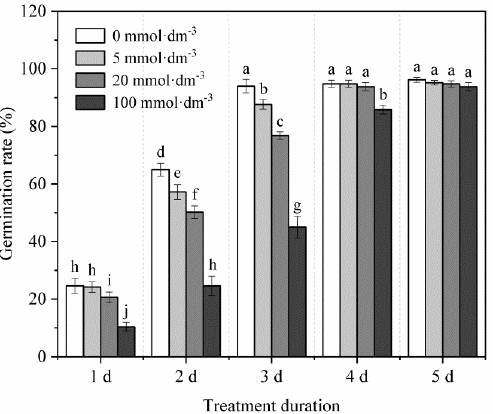
Figure 1. Effects of IDS on maize seed germination. Maize seeds were treated with different concen- trations (0, 5, 20, and 100 mmol·dm −3 ) of the chelating agent IDS. The number of germinated maize seeds was recorded at 1, 2, 3, 4, and 5 d after sowing. Error bars represent the standard deviation of the mean ( n = 5). Means associated with different letters are significantly different between treatments and time points ( p < 0.05; Duncan’s new multiple range test). IDS, iminodisuccinic acid. Although the final GR of seeds was reduced to approximately 18% under heavy metal stress (20 mmol·dm −3 PbCl 2 ), the IDS treatment effectively alleviated the inhibitory effect of Pb stress on seed germination in maize (Figure 2). For instance, compared with the GR after the treatment with Pb alone, the GR after the treatment with 100 mmol·dm −3 IDS under conditions of Pb stress was approximately 2.03-, 1.85-, 1.86-, 1.92-, and 1.85-fold higher at 1, 2, 3, 4, and 5 d after sowing, respectively (Figure 2, p < 0.05). Similar changes were observed for maize seed germination under Pb stress in groups treated with 5 and 20 mmol·dm −3 IDS (Figure 2, p < 0.05).